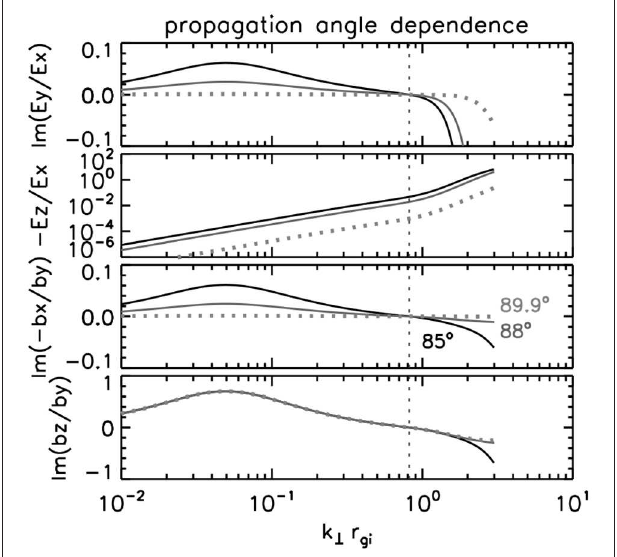
FIGURE 2 | Electric field polarization, parallel electric field, magnetic field polarization, and parallel magnetic field as a function of the perpendicular component of wavevector normalized to the thermal ion gyro-radius. Ion beta 0.01. Propagation angle 88 ◦ to the mean magnetic field. Dashed and dotted curves are the low-wavenumber and high-wavenumber approximations, respectively. Electron-to-ion temperature ratio is set to unity. Equations (18), (30), (36), (45) are used for the low-wavenumber approximation (dashed lines). Equations (21), (31), (39), (46) are used for the high-wavenumber approximation (dotted lines).